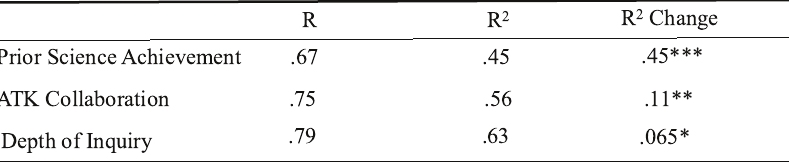
Multiple Regression of Prior Science Achievement, Collaboration (Analytic Toolkit), Depth ofInquiry on Scientific